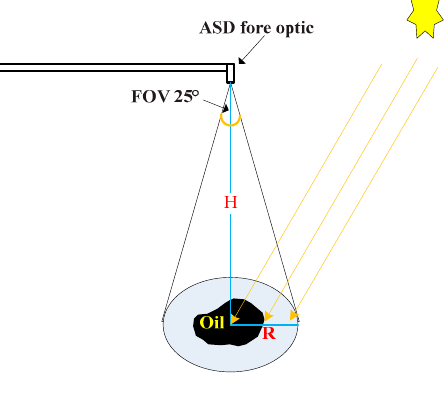
Figure 3. Observation geometry.